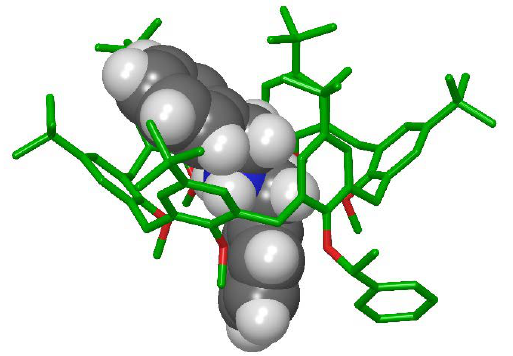
Figure 4. DFT-optimized structures of 8 + @ ( R )- 4 pseudo[2]rotaxane at the B97D3 / SVP / SVPFIT level of